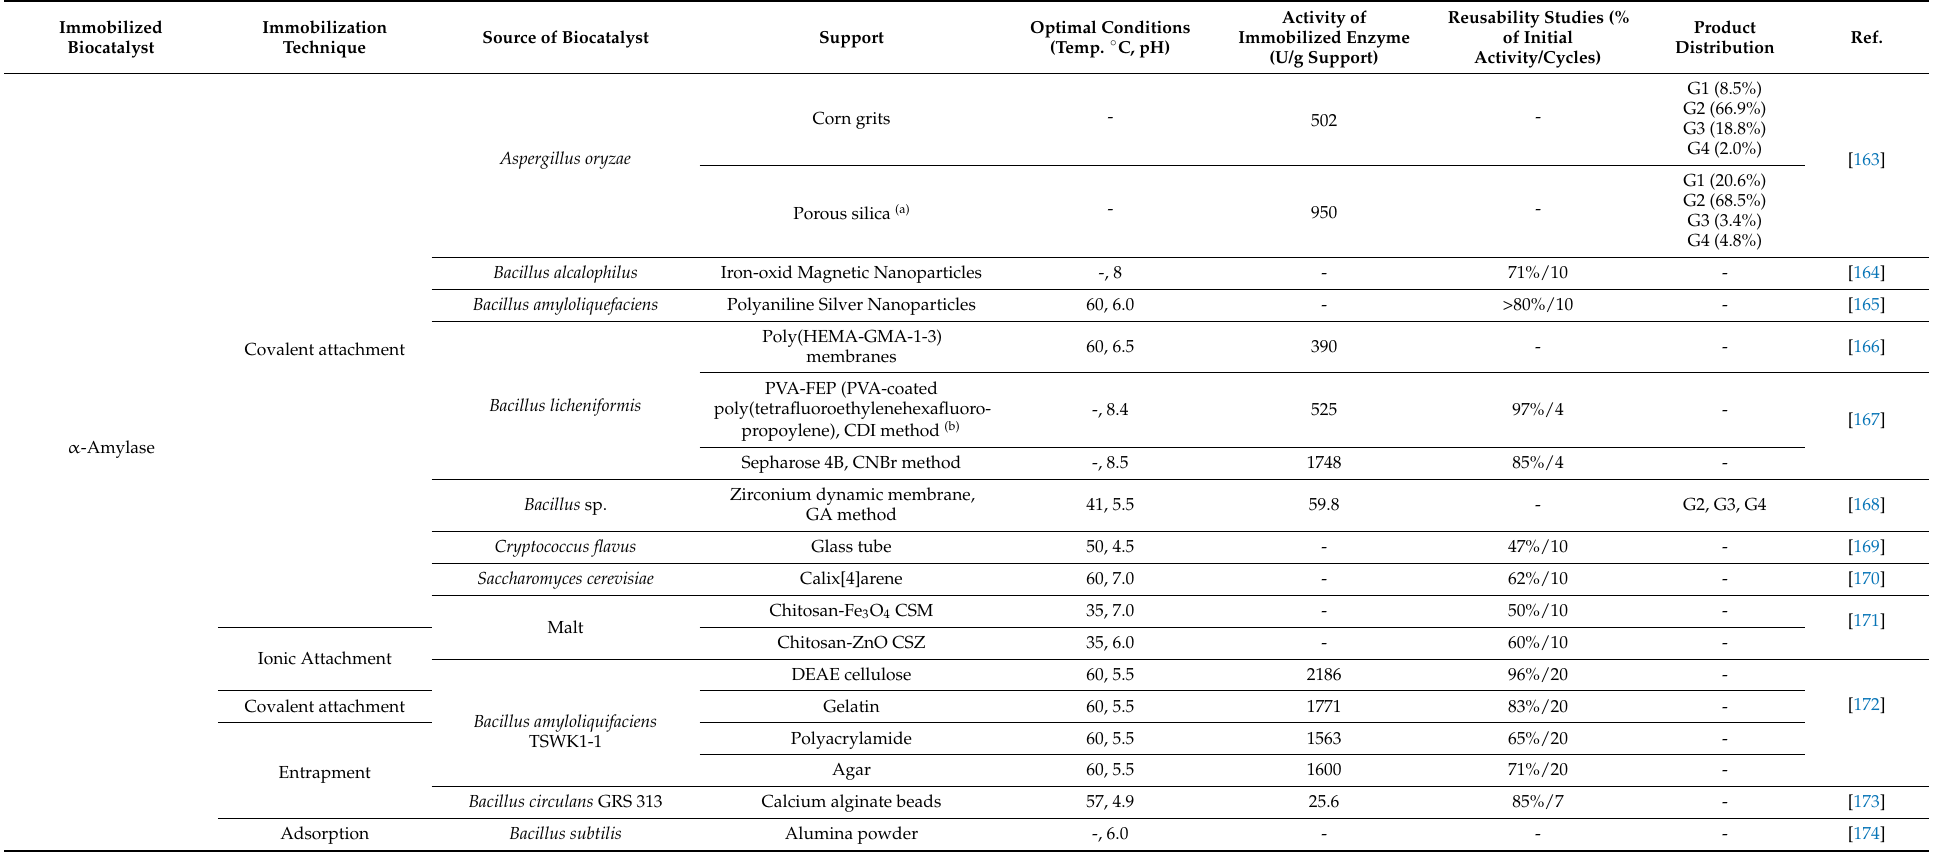
Table 4. Summary of selected immobilized α -amylases and MFAses. Starch was used as a substrate in all studies with one exception, reduced shortchain amylose in the study of immobilized G4-Amy on Diaion HP-50